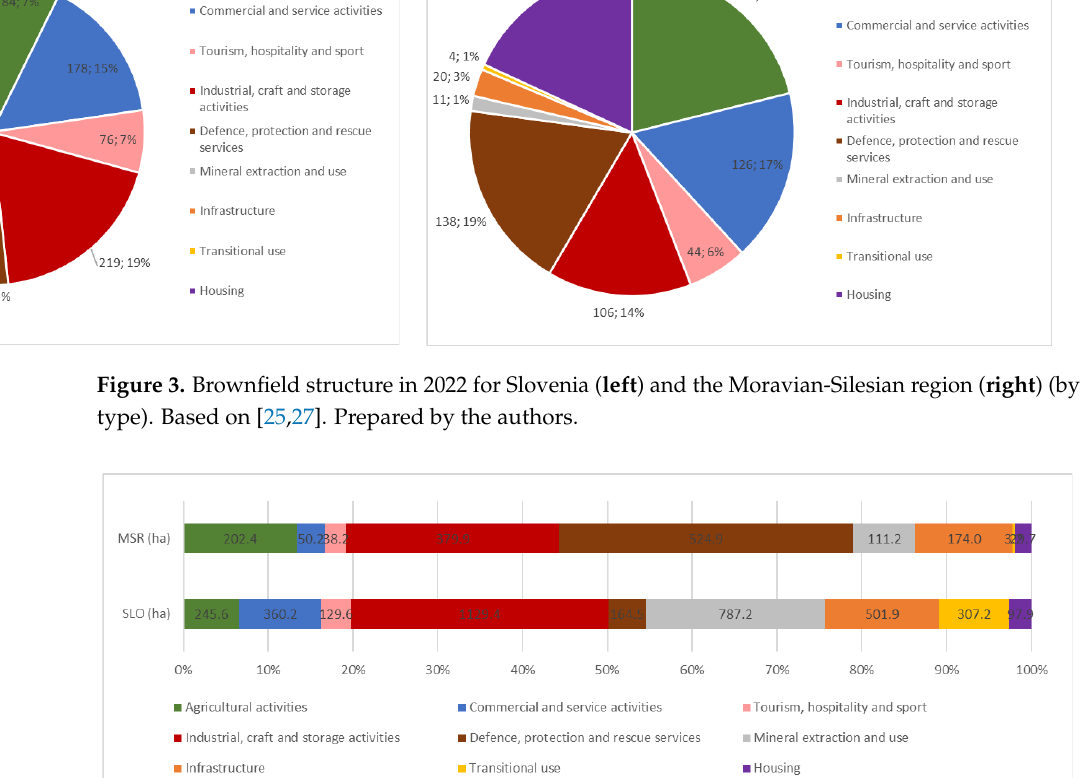
Figure 3. Brownfield structure in 2022 for Slovenia ( left ) and the Moravian-Silesian region ( right ) (by type). Based on [25,27]. Prepared by the authors.